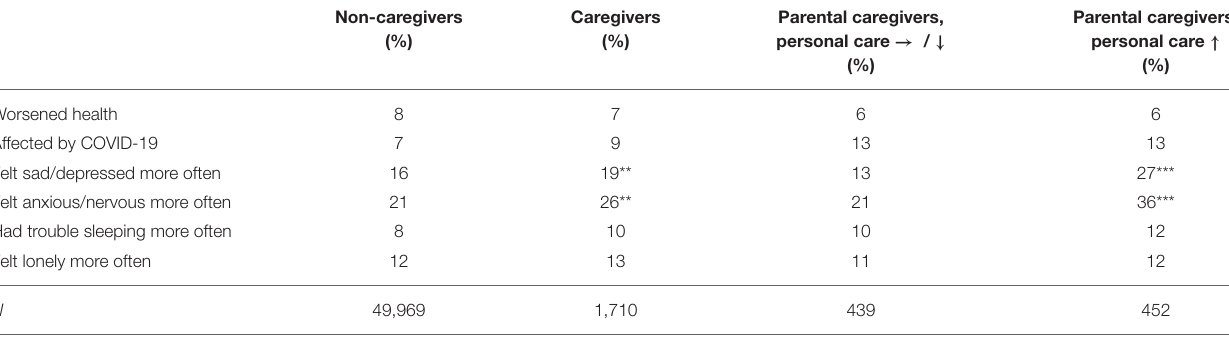
TABLE 1 | Adjusted predictions of health-related outcomes by caregiving and changes in parental caregiving.